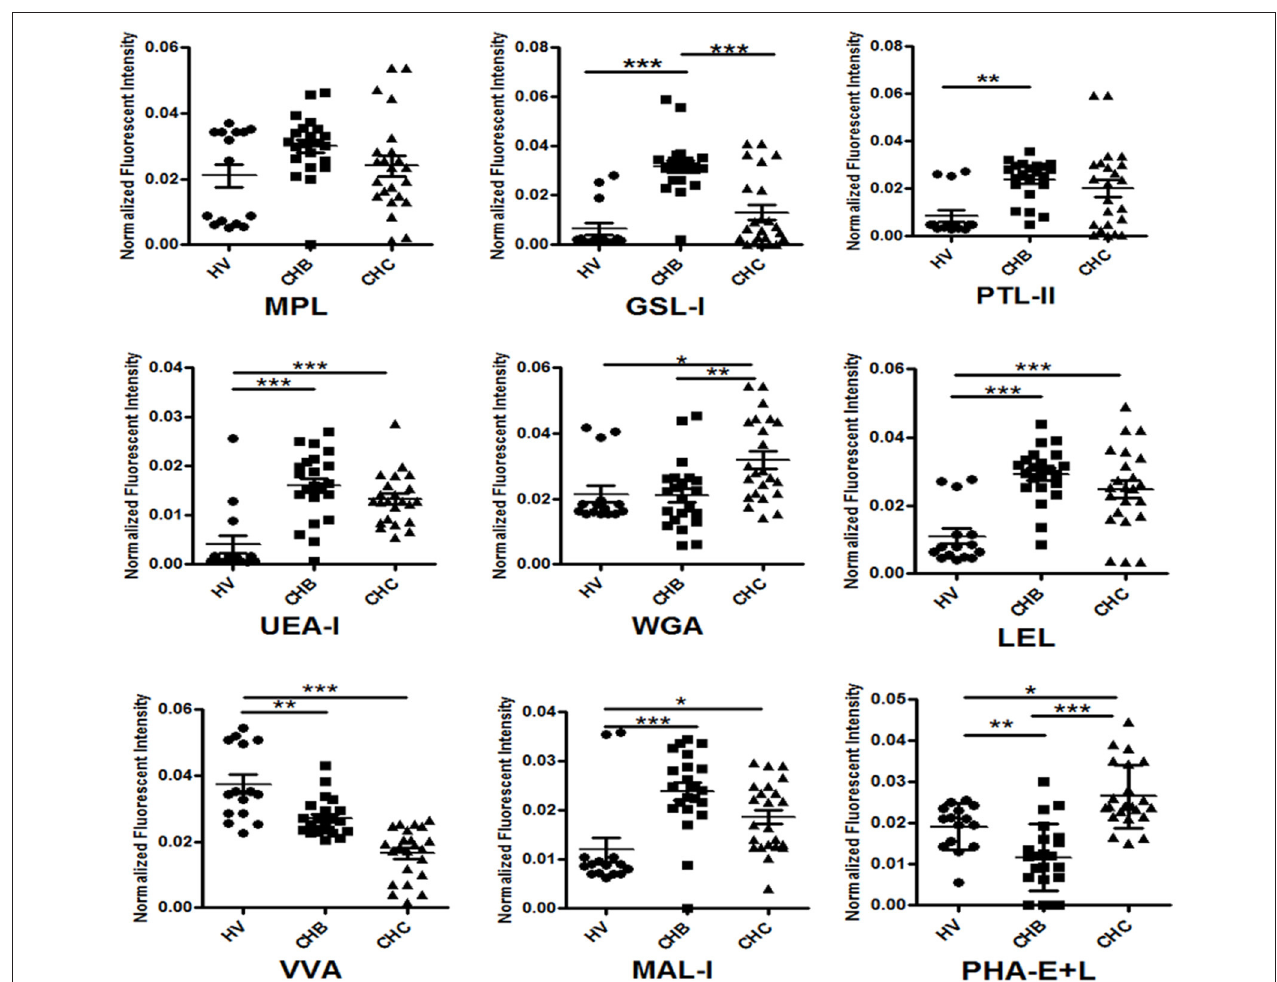
FIGURE 2 | Individual glycopattern analysis in sera from HVs, CHB, and CHC patients. Scatterplots of the data were obtained with lectin microarrays. Significant differences between HVs, CHB, and CHC patients were analyzed by a non-parametric one-way ANOVA (* p < 0.05, ** p < 0.01, and *** p < 0.001).